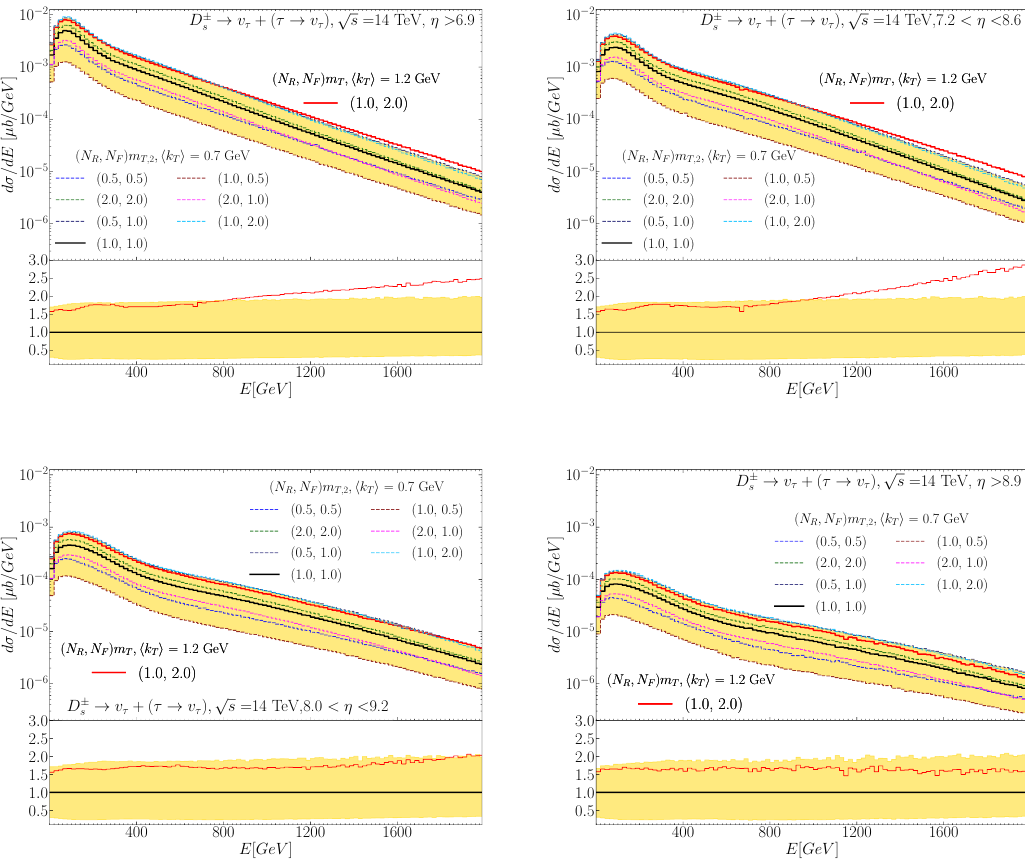
Figure 13. Central predictions and scale uncertainties using as input ( µ R , µ F ) = (1 , 1) m T, 2 and h k T i = 0 . 7 GeV (black histograms and bands) for the E ν distributions for η ν > 6 . 9 (upper left), 7 . 2 < η ν < 8 . 6 (upper right), 8 . 0 < η ν < 9 . 2 (lower left) and η ν > 8 . 9 (lower right) in pp collisions √ with s = 14 TeV. Also shown are energy distributions for scales (1 , 2) m T with h k T i = 1 . 2 GeV (red solid). The scale dependence envelope relative to the central scale choice of ( µ R , µ F ) = (1 , 1) m T, 2 is shown in the ratio plot for each rapidity range. The ratio of the (1 , 2) m T , h k T i = 1 . 2 GeV prediction to the central prediction with the default parameter set is also shown with the red line in each ratio